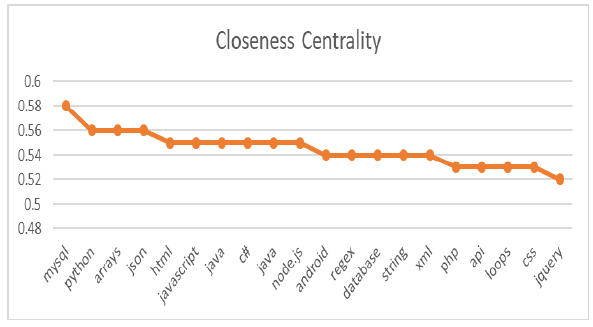
Figure 18. Closeness